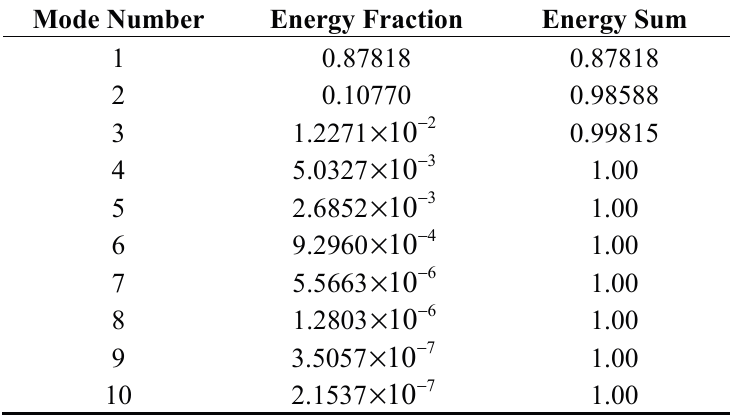
Table 6. Energy content of the first ten eigenfuctions of the KL